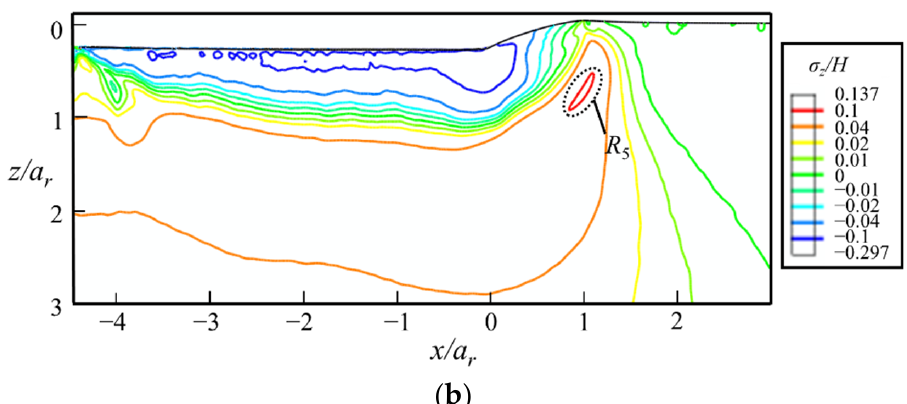
Figure 17. The contours of ( a ) σ y / H and ( b ) σ z / H at the fully unloaded state in the xz -cross-section predicted by FEA. The indenter moves along the positive direction of x -axis.